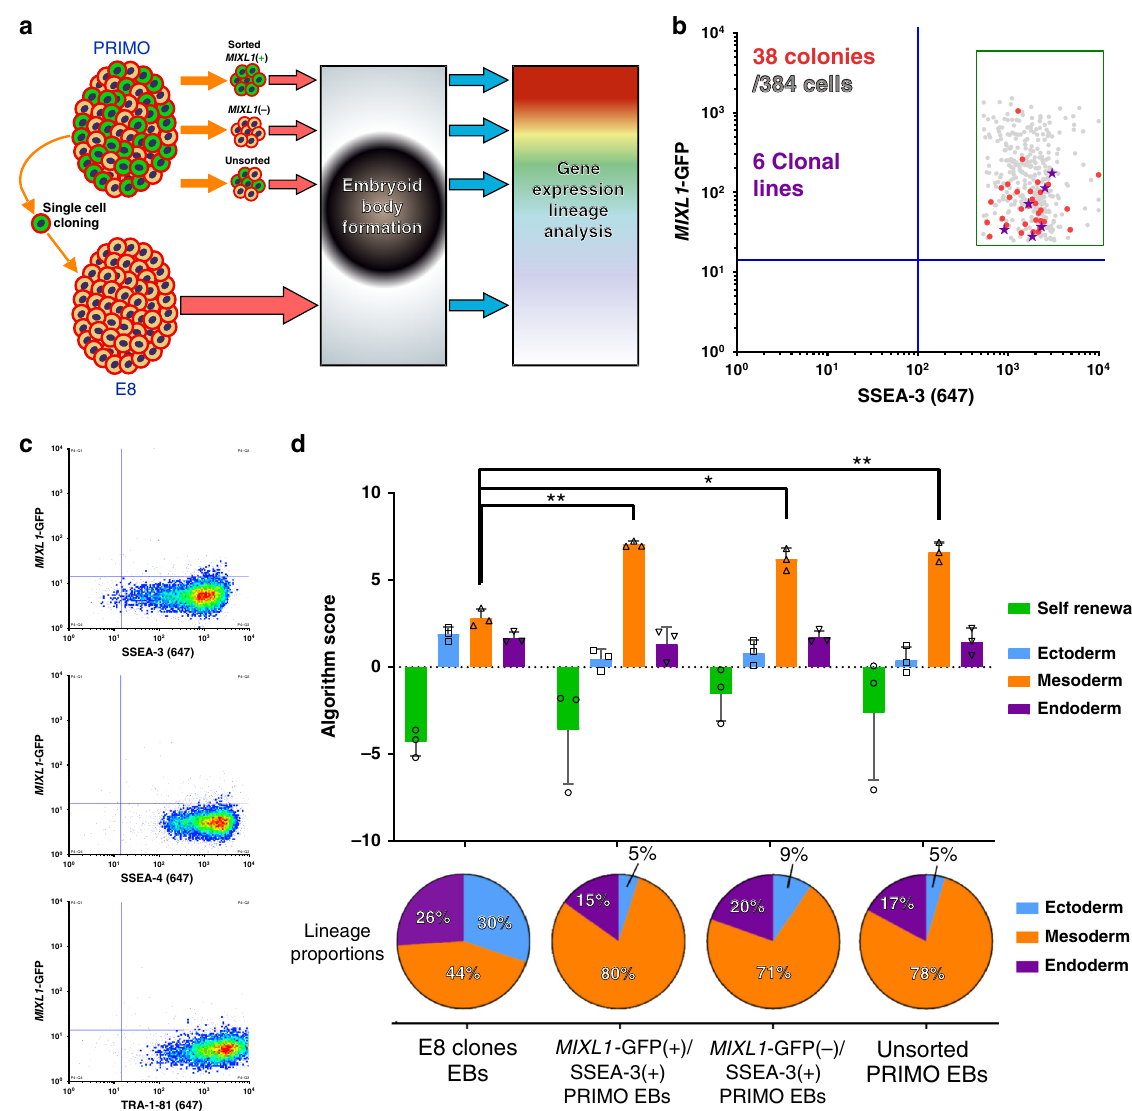
Fig. 5 Cells in PRIMO exhibit a mesoderm bias under differentiation conditions and retain clonogenic potential. a A schematic diagram of the experimental process. Cells were grown in PRIMO Plus conditions for 3 days then cells were taken, unsorted or sorted for MIXL1 -GFP( + )/SSEA-3( + ) and MIXL1 -GFP( − )/SSEA-3( + ), and put through a neutral EB assay. After 7 days EBs were harvested and assessed for gene expression by hPSC scorecards. Separately single MIXL1 -GFP( + )/SSEA-3( + ) cells were sorted from cells grown in PRIMO conditions and clonal lines were established, these lines were then assessed by the same neutral EB assay. b Single cells from MIXL1 /SSEA-3 double positive fraction were sorted into four 96 well plates. The MIXL1 / SSEA-3 scatter plot shows the indexed positions of the 38 isolated cells that formed colonies (red circles), including 6 that were selected randomly to generate clonal lines (purple stars) from 384 sorted cells (grey circles), a cloning ef fi ciency of ~10%. c Flow cytometry density plots of clone 10-A4 grown in E8 conditions for surface markers SSEA-3, SSEA-4 and TRA-1-81 versus MIXL1 -GFP, revealed high surface marker expression and virtually no MIXL1 -GFP expression. d A bar chart displaying the algorithm score for each sample, for self renewal and three lineages, ectoderm, mesoderm and endoderm. The algorithm score is calculated based on the qPCR values for genes of a given lineage, the 0 baseline is based on the average value of undifferentiated samples. EB samples have been normalised to their undifferentiated counterparts (bars are mean ± SD, n = 3 biological replicates, signi fi cance assessed by two-way ANOVA analysis corrected for multiple comparisons, p values left to right are (**) p = 0.0026, (*) p = 0.0177 and (**) p = 0.0071). Below the bar chart are lineage proportion pie charts of the algorithm scores generated for the three germ layers. All samples grown in PRIMO medium generated EBs with enhanced mesoderm signatures, whereas clonal lines grown in E8 generated EBs containing all three germ layers with more similar proportions. b , d Source data are provided as a Source Data fi